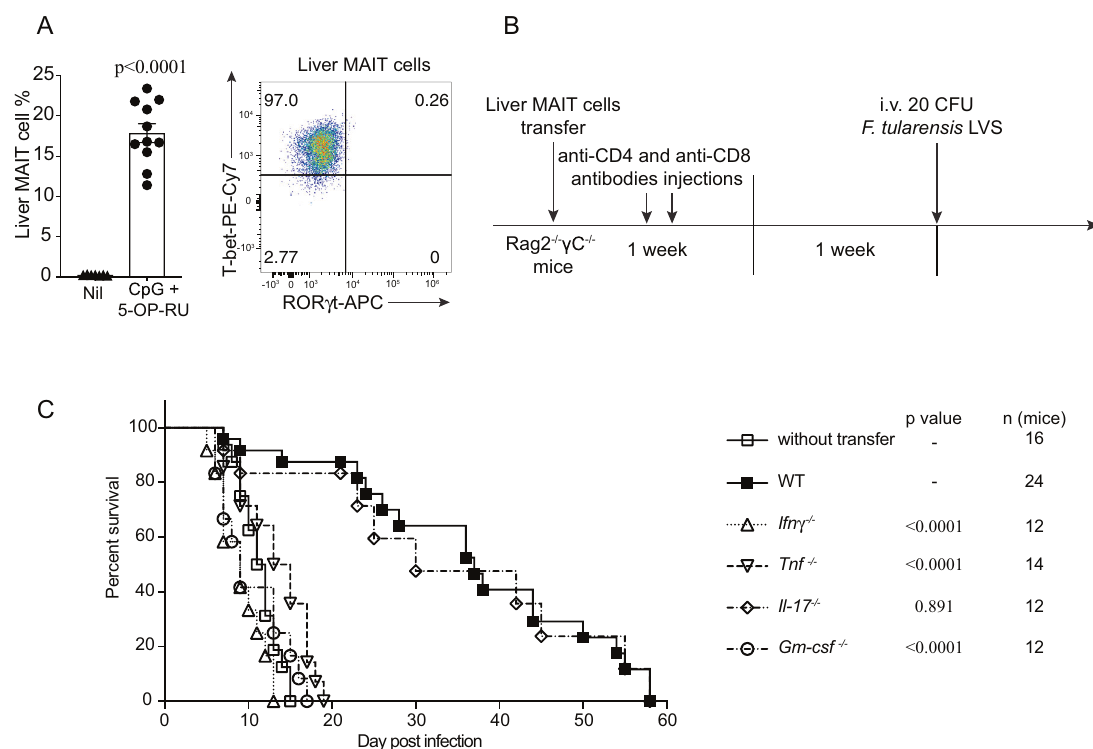
Fig. 7 MAIT cell-mediated protection in immune-compromised mice requires IFN γ , TNF, and GM-CSF. A MAIT cell percentage of αβ -T cells in the liver and representative FACS plot showing intranuclear staining for T-bet and ROR γ t of MAIT cells from donor C57BL/6 mice vaccinated with CpG and 5-OP- RU i.v. for 7 days, prior cell sorting for adoptive cell transfer. Pooled data from 7 (nil) or 11 (vaccinated) mice from 3 independent experiments (mean ± SEM). Unpaired t -test (two-tailed). P < 0.0001. B Schematic of protocol for MAIT cell adoptive transfer and F. tularensis LVS challenge: 10 5 liver MAIT cells from C57BL/6 (WT, shown in A ), Ifn γ − / − , Tnf − / − , Gm-csf − / − , or Il-17 − / − mice vaccinated with CpG (10 nmol) and 5-OP-RU (2 nmol) i.v. for 7 days were sorted by fl ow cytometry and transferred i.v. into Rag2 − / − γ C − / − mice. The mice were treated with anti-CD4 and anti-CD8 mAb injection (i.p., 0.1 mg each) at days 1 and 3 post MAIT cell transfer, to deplete contaminating conventional T cells. After 2 weeks, mice were infected with an otherwise lethal dose (20 CFU) of F. tularensis LVS i.v. C Survival of untreated Rag2 − / − γ C − / − mice or Rag2 − / − γ C − / − mice following transfer of MAIT cells from WT, Ifn γ − / − , Tnf − / − , Gm-csf − / − , or Il-17 − / − mice according to schematic shown in B . Pooled data from two independent experiments with similar results ( n = 12 – 24 mice per group, as indicated). Log-rank tests ( Ifn γ − / − , Tnf − / − , Gm-csf − / − , and Il-17 − / − groups were compared with WT group). P -values